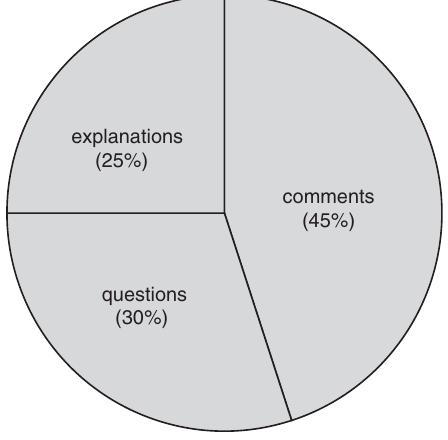
FIG. 3. Distribution of annotation